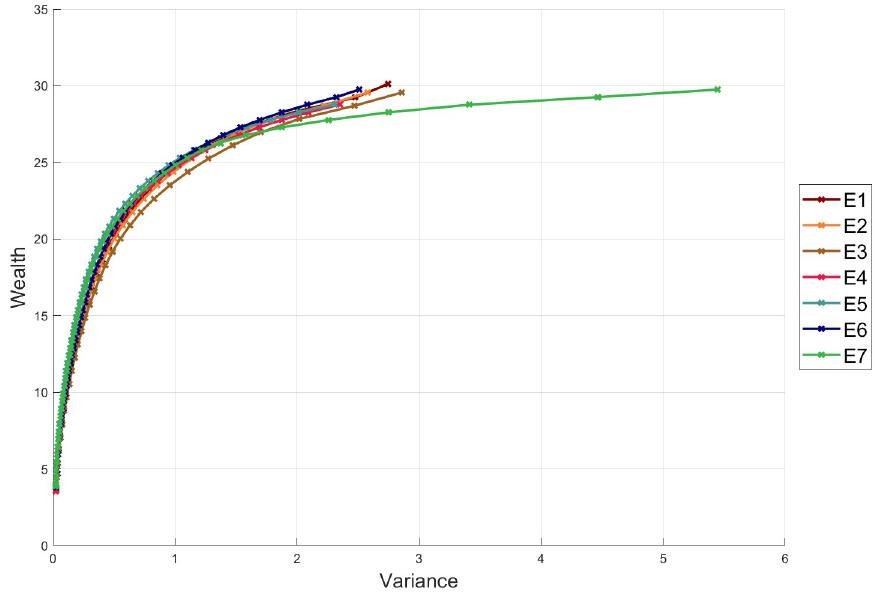
Fig 6. Pareto efficient